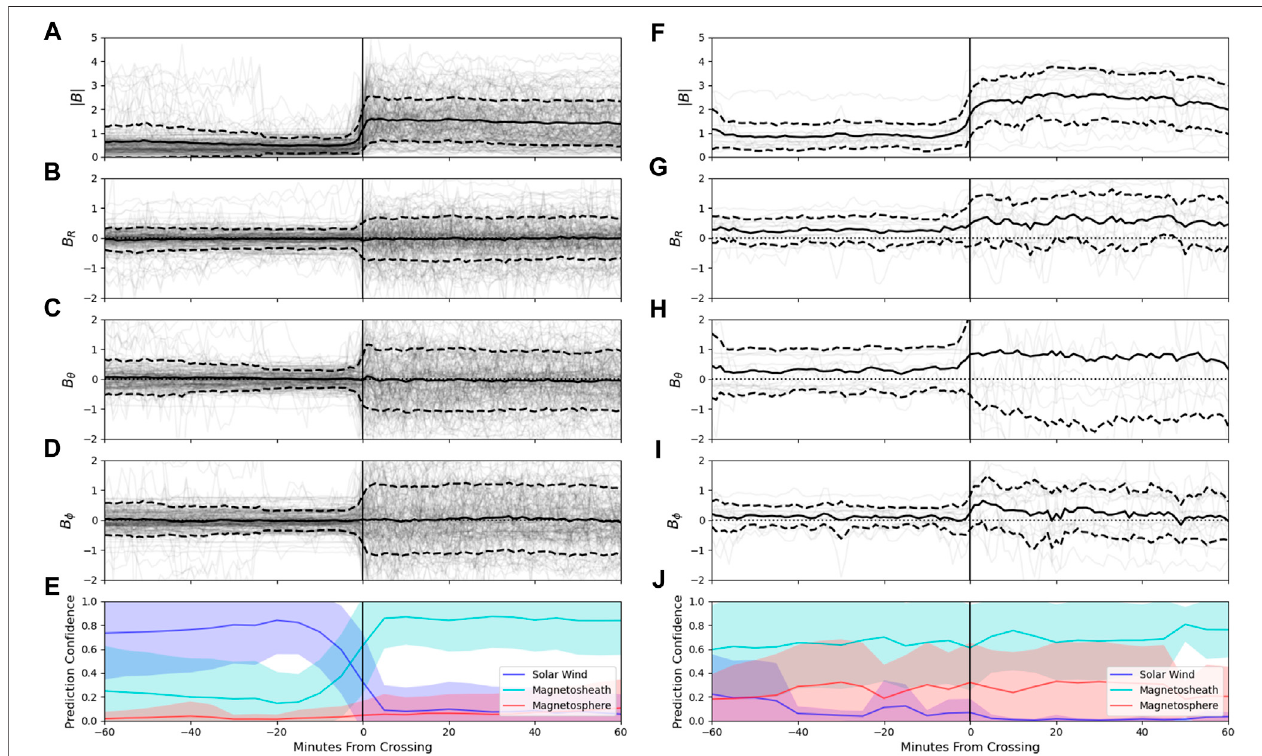
FIGURE 10 | Comparison of the bow shock crossings in the labeled data set which were matched to a predicted crossing (A-E) , versus those which were not matched (F – J) in the RNN 60-min model predictions. Panels (A – D) and (F – I) show the magnetic fi eld conditions in a 1-h vicinity surrounding the labeled crossing, with individual instances plotted as transparent black lines. The average conditions ± the standard deviation are shown as thick black solid and dotted lines, respectively. Panels (E,J) show the prediction con fi dence of the model surrounding the labeled crossing for matched (E) and unmatched (J) crossings, with the average ± the standarddeviationshownintheshadedregion.Heretheinwardsandoutwardscrossingshavebeenoverlaid,suchthatallcrossingsareorientedinainwardstrajectory. In total there were 155 matched crossings and 15 unmatched crossings (see Table 4